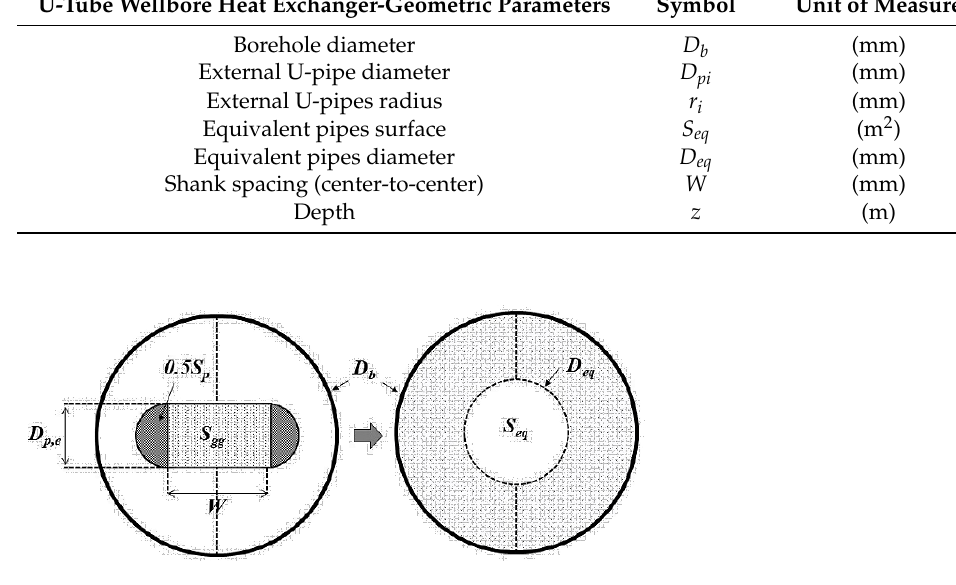
Figure 4. Geometrical model characteristics for calculating the equivalent diameter (modified from [22]. Copyright Elsevier, 2014).